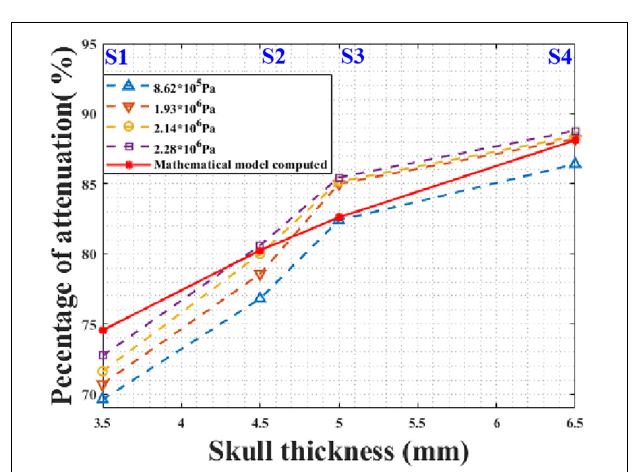
FIGURE 10 | Peak sound pressure attenuation results for different initial sound pressures at different test points of skull No. 14.